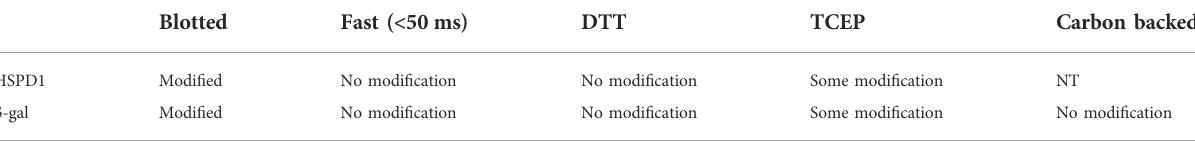
TABLE 1 Summary of the modi fi cations seen in HSPD1 and β -gal and the different parameters tested. NT = not